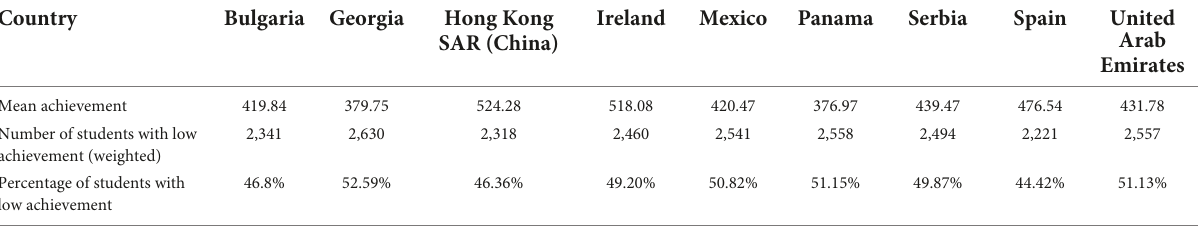
TABLE 5 Mean performance in reading for each country and number of students with low achievement.